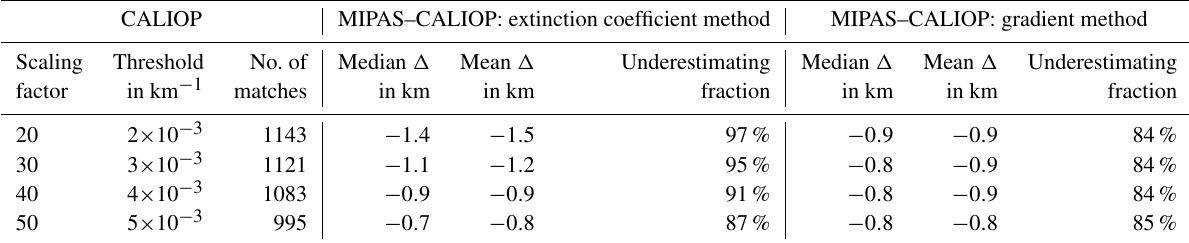
Table 4. Difference between MIPAS and CALIOP cloud top height of the Nabro sulfate aerosol for the extinction coefficient threshold method and the gradient method for a possible set of scaling factors determining the altitude-variable extinction detection threshold, where the threshold value is given at